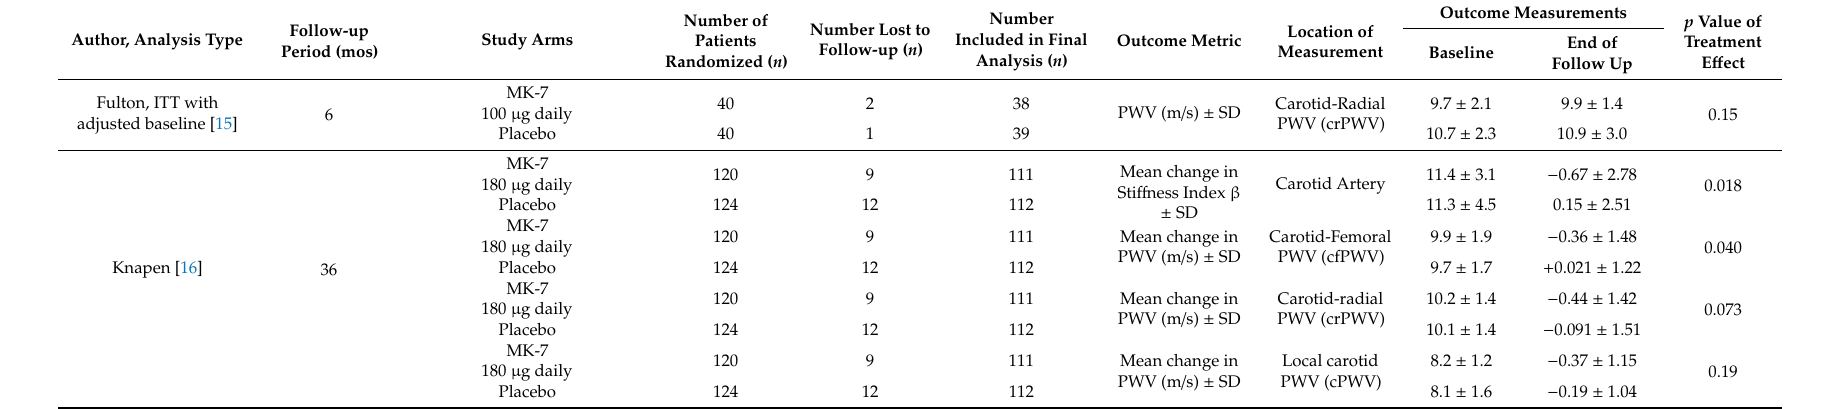
Table 6. E ff ect of vitamin K supplementation on arterial sti ff ness